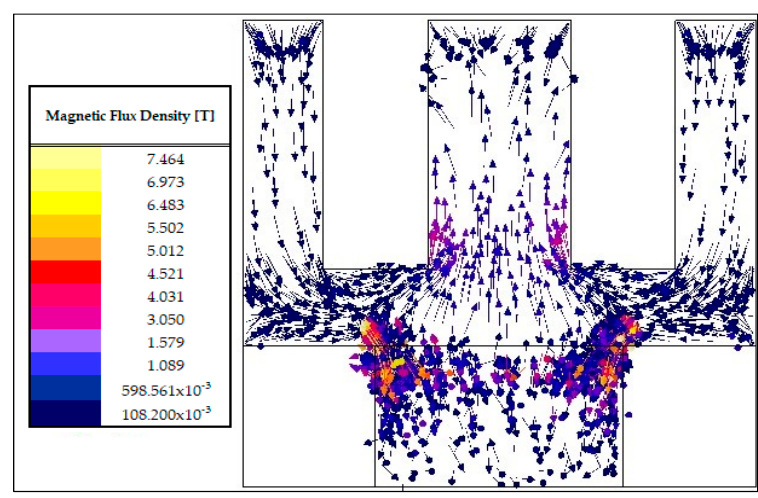
Figure 20. Longitudinal magnetic field density.